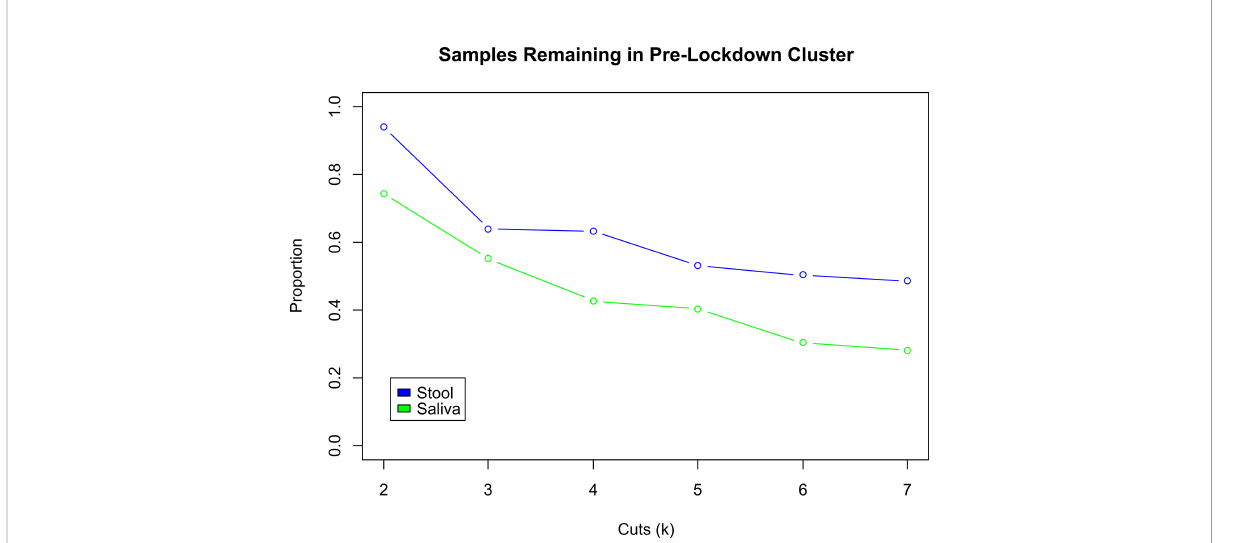
FIGURE 4 Comparison of Proportion of Subjects Changing Clusters between Stool and Saliva. These two curves illustrate the change in the proportion of early pandemic samples that remain in the same cluster as their pre-pandemic sample, for stool (blue) and saliva (green) samples. As the hierarchically clustered samples are cut from k = 2 to 7 clusters, the cluster sizes decrease and become more exclusive. Thus, any two samples that are in the same cluster when k = 7 are more similar to each other, than when k was smaller, e.g., 2. Across all cuts k , the early pandemic stool samples tend to be consistently closer to their pre-pandemic mates, than the saliva samples. At k = 2, the proportion of pre- and early pandemic stool samples that in the same cluster are 93.8%, compared to 74.2% in saliva. At k = 7, 48.6% of stool vs. 28.1% of saliva pre- and early pandemic samples are collocated in the same